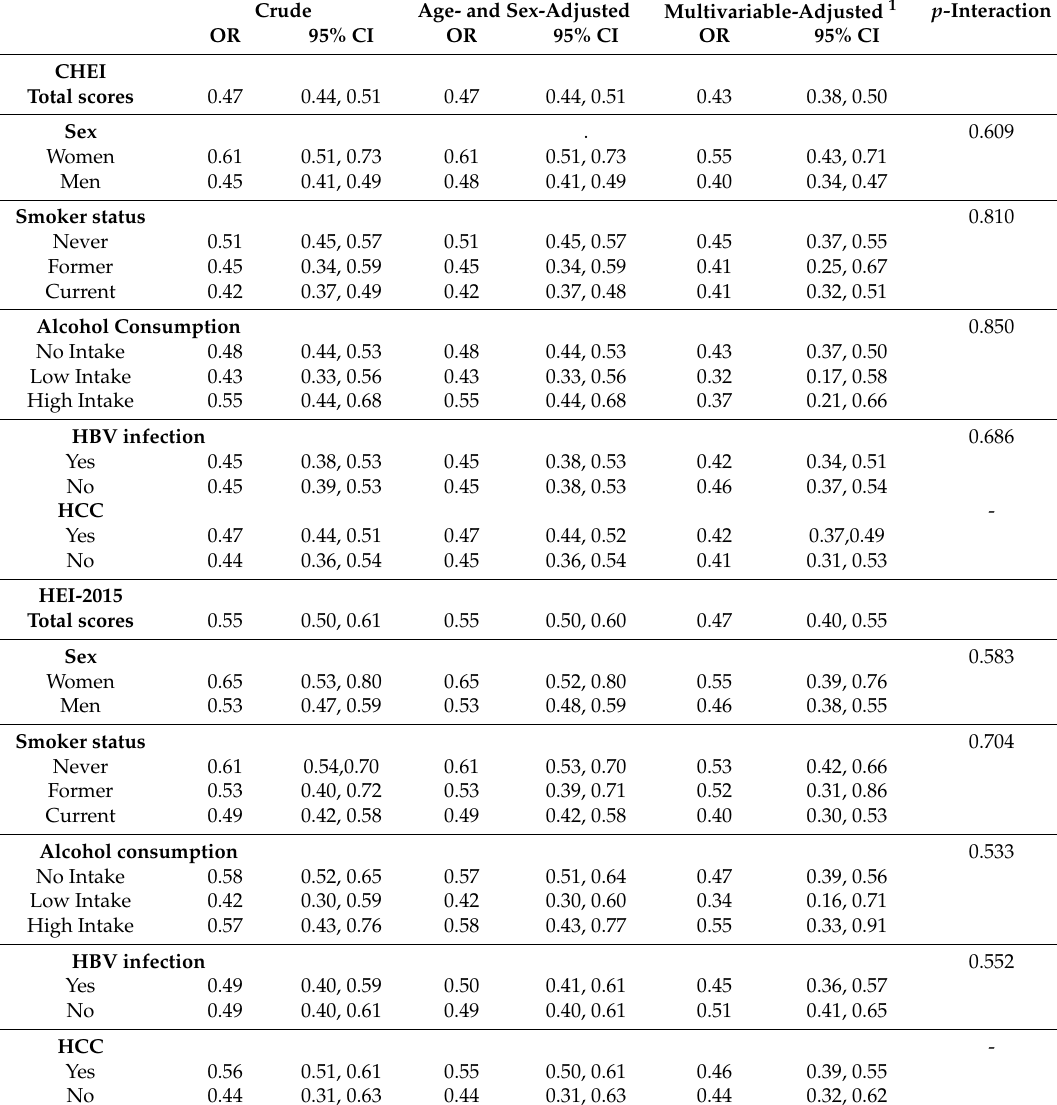
Table 2. ORs (95% CIs) for primary liver cancer per 5-point increment of diet-index scores stratified by selected